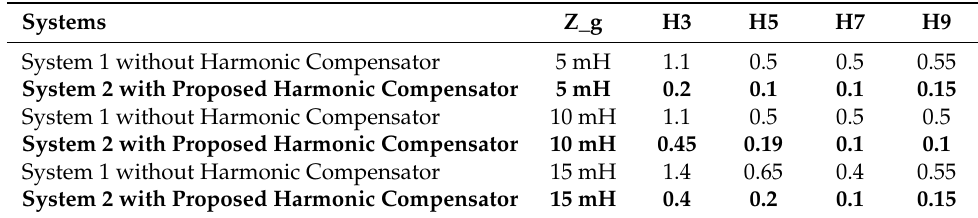
Table 2. First four odd harmonics comparisons.